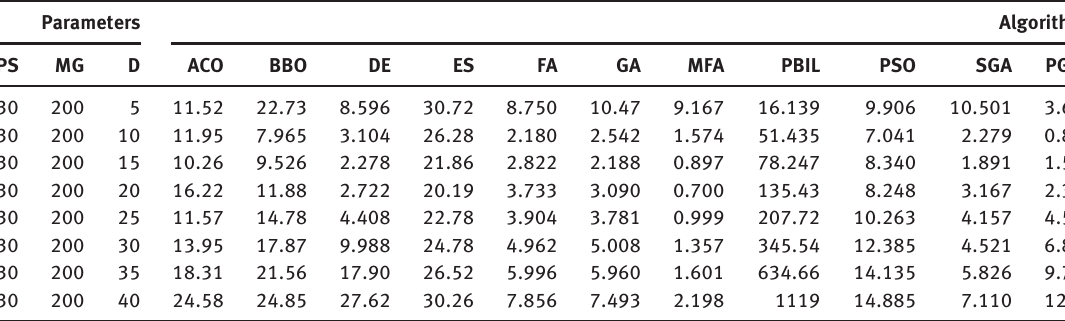
Table 10. Mean Optimization Results on Different Dimensions.